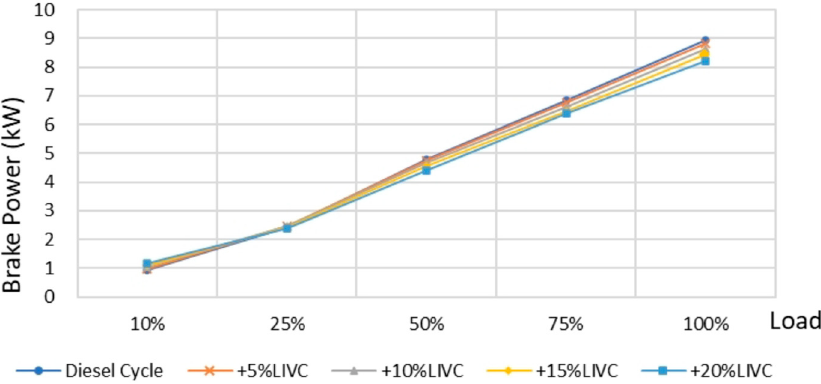
Figure 7. Comparison of BP under diesel engine LIVC Miller cycle.